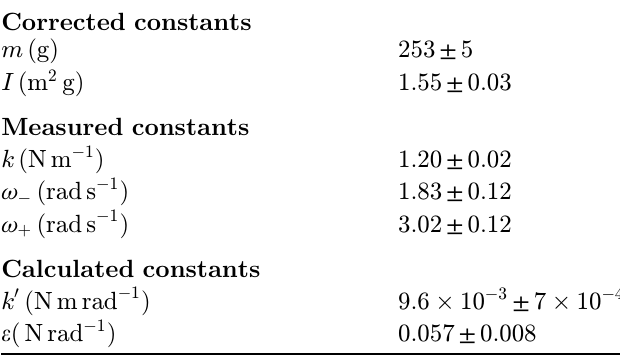
Table 3. Corrected, measured and calculated constants of the